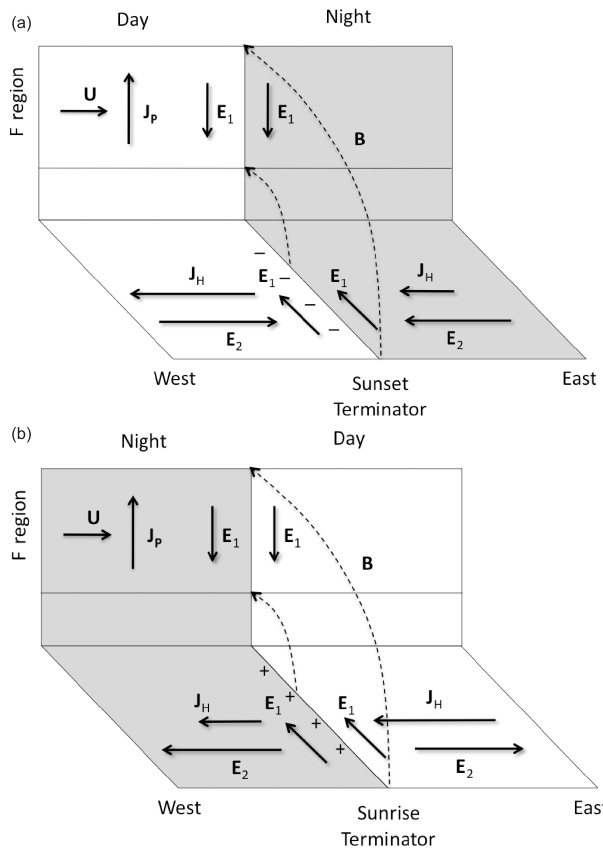
Figure 5. Sketches illustrating the processes responsible for en- hancements in the vertical drifts around (a) sunset and (b) sunrise hours, following the mechanism proposed by Farley et al.